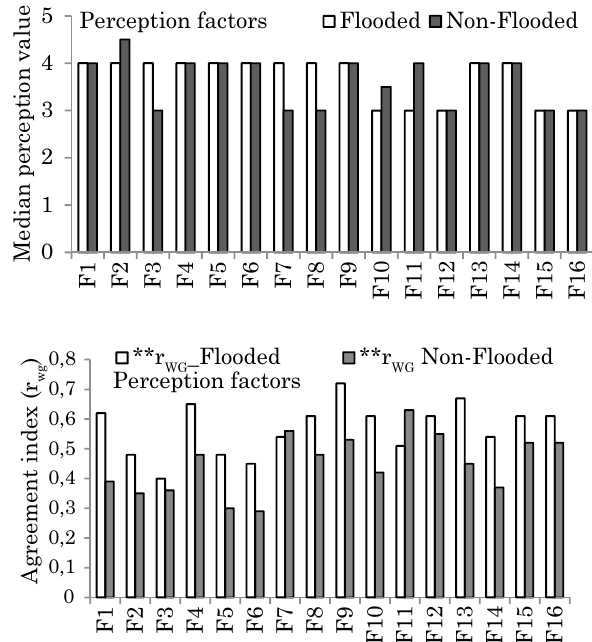
fig. 3. observed agreement (top) and r difference between flood affected and